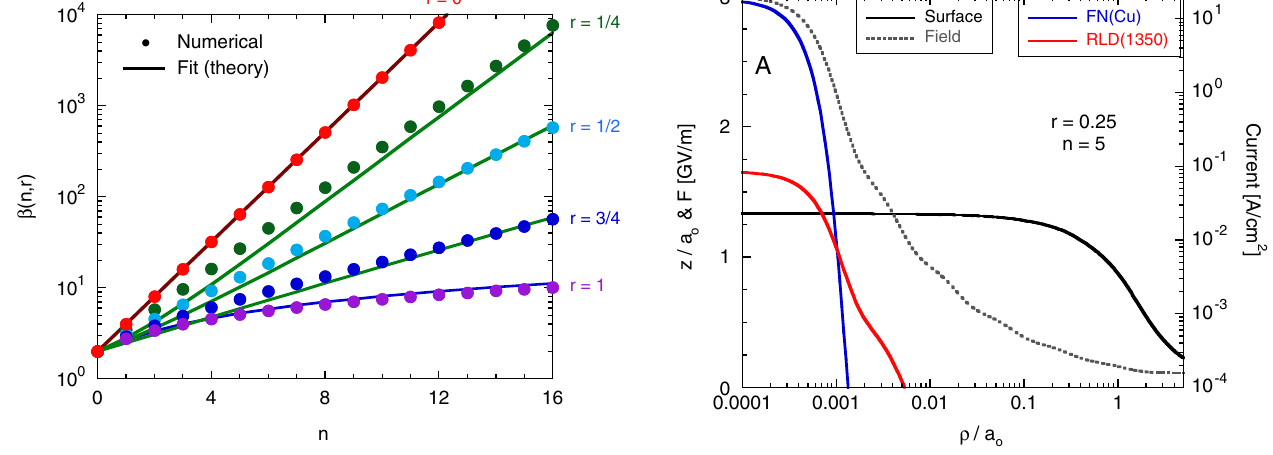
(cid:3) r (cid:4) as a function FIG. 8. (Color) The field enhancement factor (cid:3) FIG. 9. (Color) The equipotential surface z (black) and field n (cid:4) is approximately linear, of n for various r . For small r , ln (cid:3) (cid:3) (dashed) contrasted with the current density (blue for field, red n indicating that field enhancements are for thermal) as a function of the cylindrical distance from the axis for small r : note first that the field emission current dominates only very close to the apex, and second that both field and thermal current contributes.